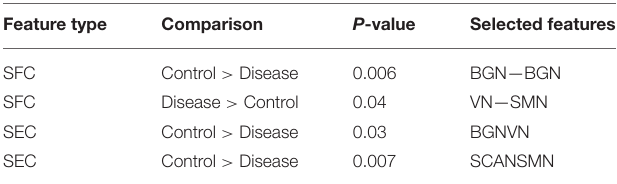
TABLE 15 | Network-to-network interactions selected by enrichment analysis for ADHD dataset. Feature type